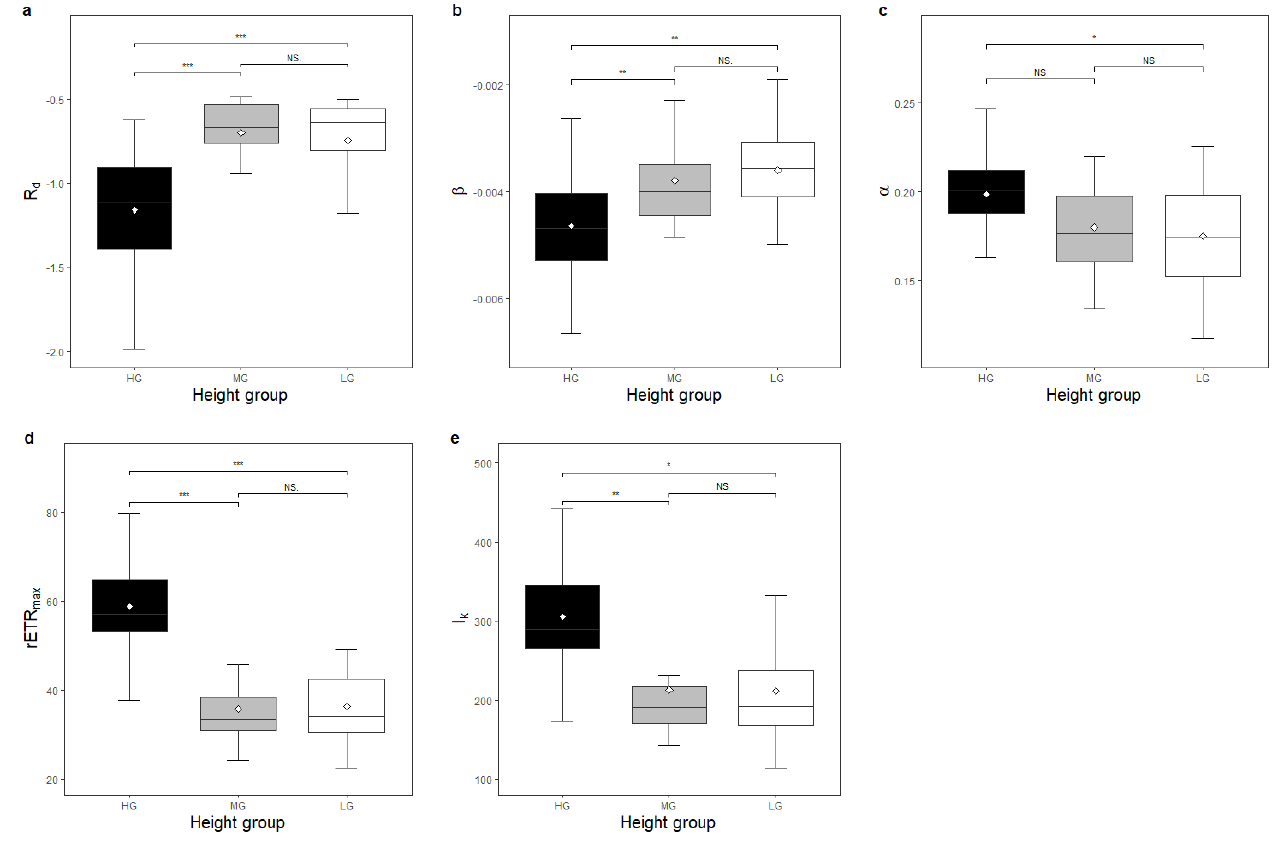
Figure 2. Photosynthetic trait differences among height groups. Differences in each trait were checked using the Tukey test at a 95% family − wise confidence level. HG refers to the higher height group, comprising Machilus breviflora , Schima superba , and Castanopsis chinensis; MG refers to the middle height group, comprising Cryptocarya concinna and Cr . chinensis; LG refers to the lower height group, comprising Ca. fissa and M . chinensis . Black box represents HG, grey box represents MG and white box represents LG in ( a – e ). R d : the rate of leaf dark respiration; β : photoinhibition coefficient of relative electron transport rate versus photosynthetic photon flux density curve (RLCs); α : initial slope of RLCs; rETR max : maximum relative electron transport rate; I k : half saturating irradiance. *** p < 0.001; ** p < 0.01; * p < 0.05; NS for not significant difference.